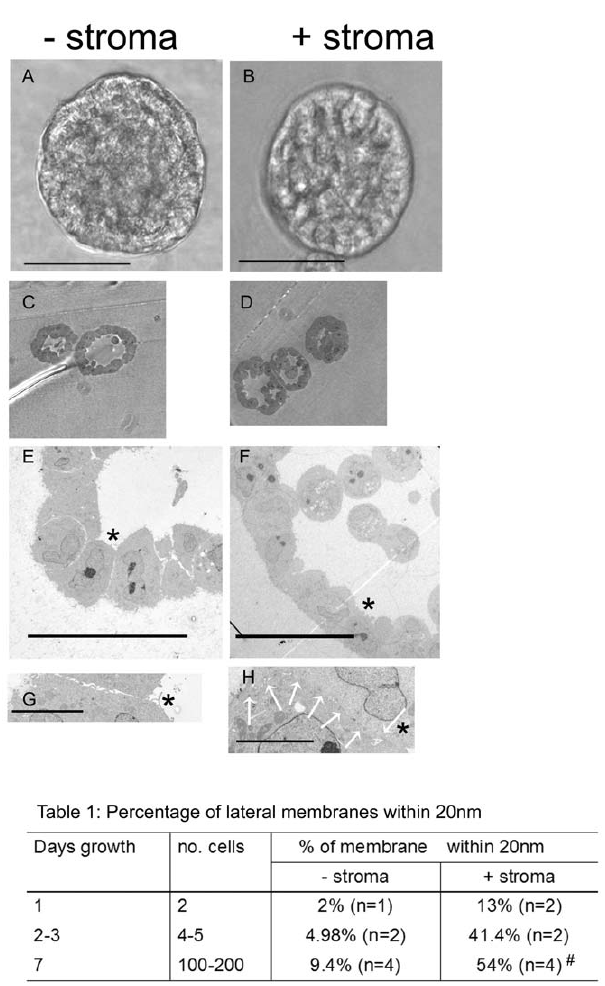
Figure 1. Stromal co-culture increases lateral epithelial cell adhesion. (A and B). Phase images of 3D BPH-1 acini grown with (B) and without stroma (A) for 8 days, bars =50 m m. Thick sections (C,D) and TEM (E,F) of mid-sections through BPH-1 acini, grown with (D,F) and without stroma (C,E). Bar =20 (E) or 50 m m (F). (G and H). High magnification TEM images of the junctions marked by the asterisks in (E) and (F). The lateral cell-cell contact shown in (H) is highlighted by white arrows, bars =5 m m. Images are representative of three spheroids analysed per experiment. The values in table 1 have standard deviations of 6 15%, # =p , 0.018.